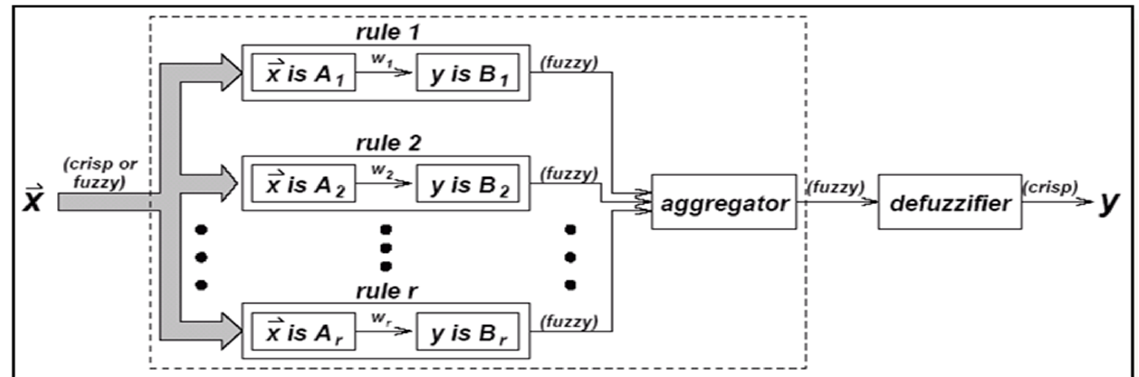
Figure 1. The fuzzy inference system phases.